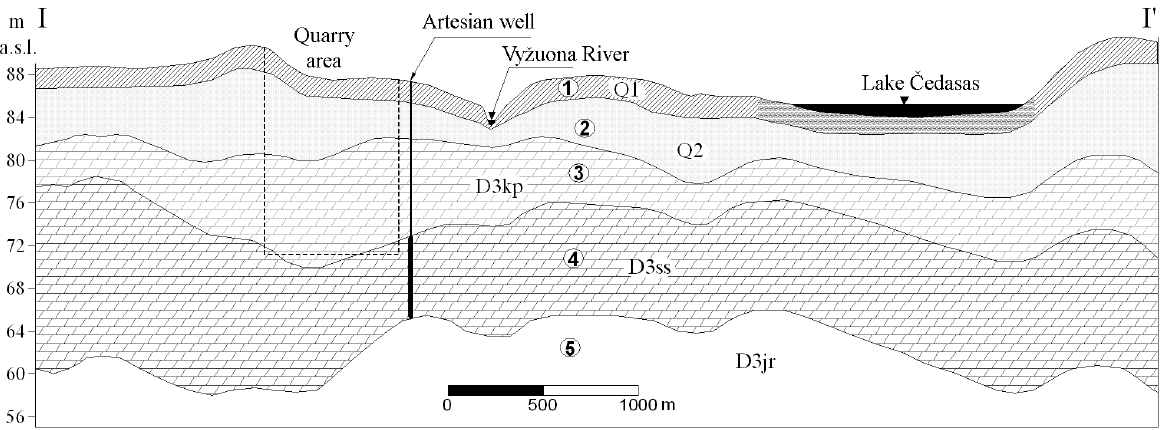
Fig. 3. Geological(cid:150)lithological cross section along line I(cid:150)I ′ (Fig. 2) of the site adjusted to the layers of the groundwater flow model. Numbers in circles (1(cid:150)5) (cid:150) layers according to Table